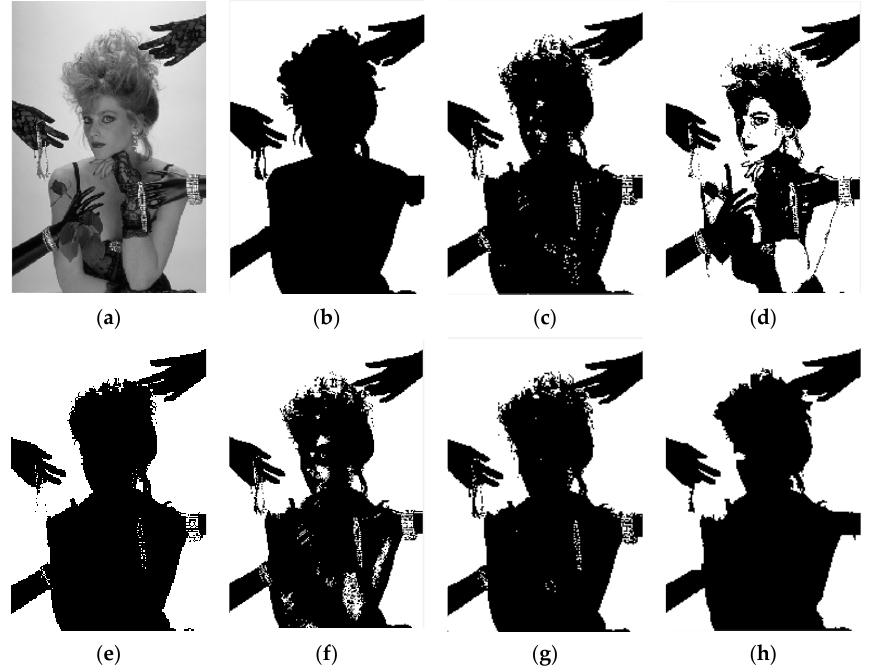
Figure 12. #198087 and its segmentations: ( a ) #198087, ( b ) ground-truth, ( c ) Otus, ( d ) MRCUT, ( e ) EITMIS, ( f ) NSWCC, ( g ) IT2FSWCC, ( h ) FSEFTISRI.